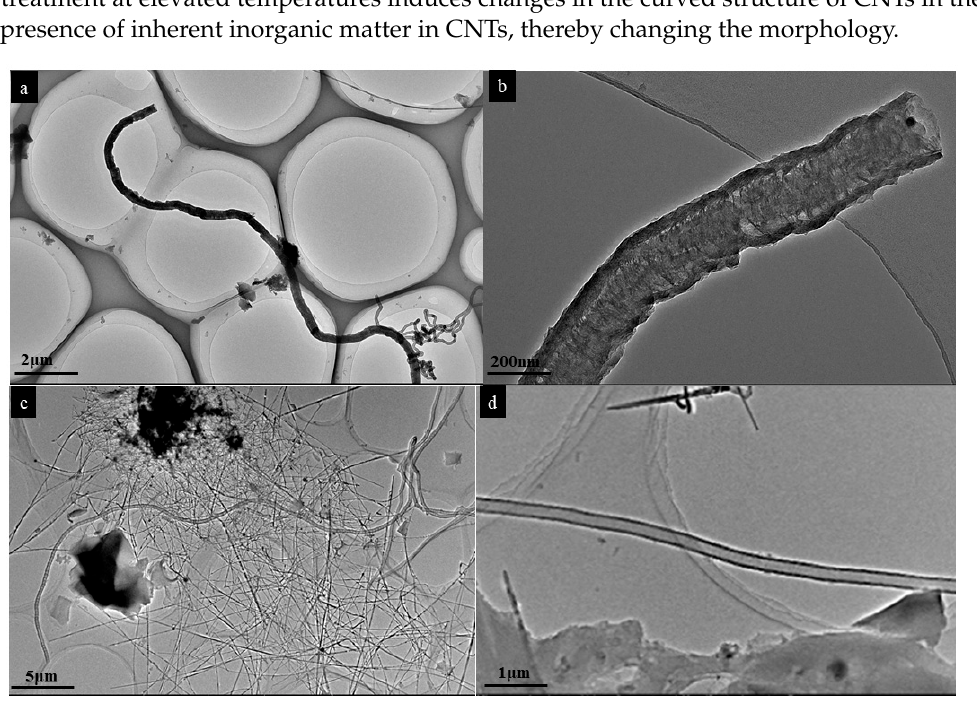
Figure 5. HR-TEM images of SL-CNTs synthesized at 1400 °C: ( a ) and ( b ) show different magnifi- cations. 3.2. Crystalline Structure of CNTs The typical peaks for CNTs in XRD spectra are generally detected at 2 θ = 26° and 2 θ = 43°, which illustrate the graphite (002) and (100) reflections, respectively [24]. Figure 6 shows two prominent peaks at 2 θ = 26.3° and 2 θ = 43.2° in the XRD spectra of CNTs after microwave treatment, suggesting that the CNTs possessed crystalline structure. The peak at 2 θ = 43.2° was not detected at 600 °C. However, after high-temperature microwave treatment, the peak became prominent. This is attributed to the increased carbon order of CNTs and a graphitic structure at higher temperatures. Si and Fe were observed in the CNT sample as their corresponding peaks were detected in the XRD spectra.